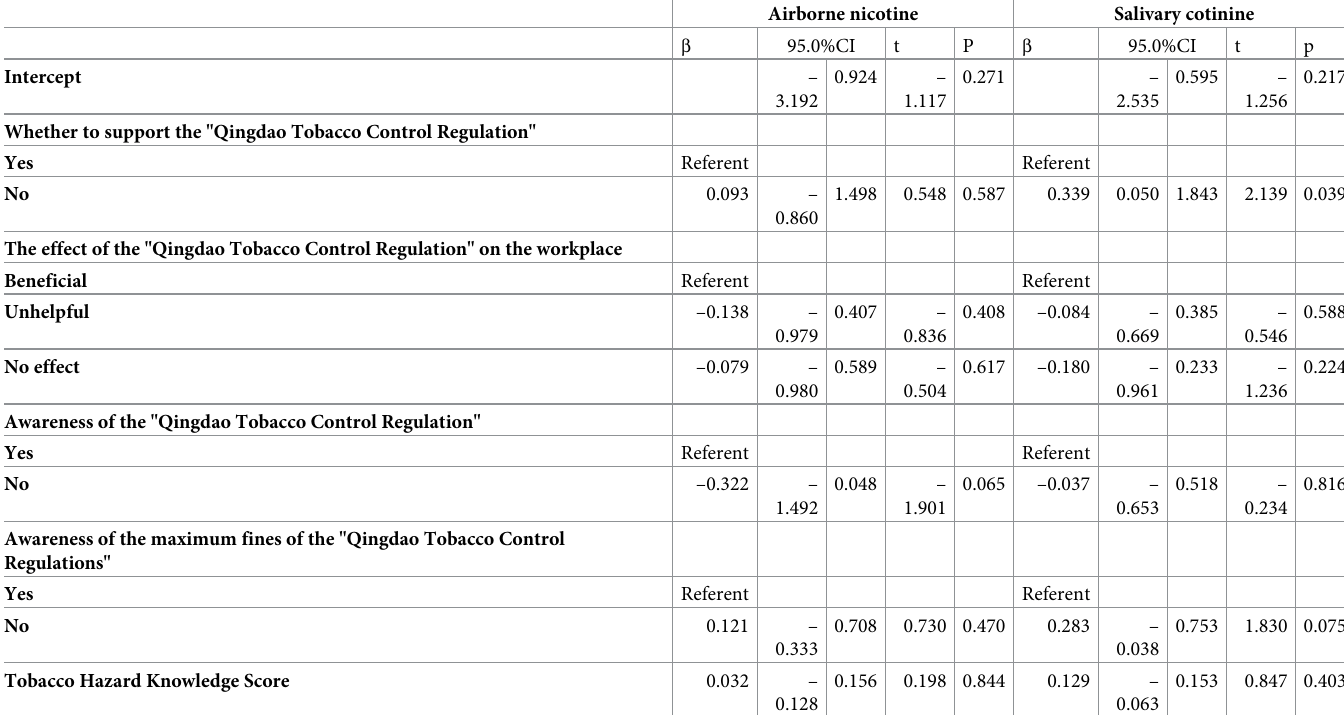
Table 4. Multivariate linear regression analysis of employers’ knowledge and attitudes towards smoking bans associated with airborne nicotine concentration and salivary cotinine concentration (N =